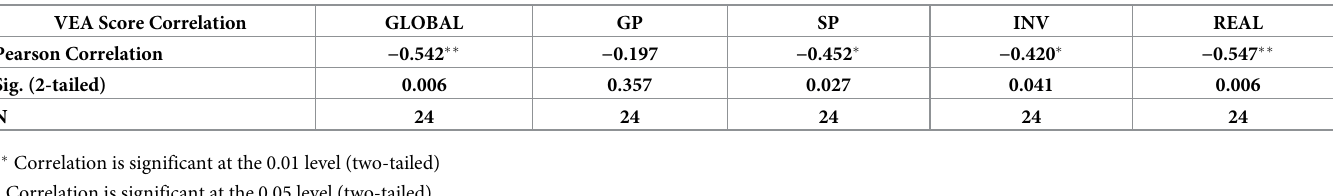
Table 3. Pearson correlation test (with Kinect).